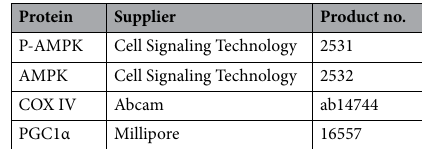
Table 2. Antibodies used in western blot analysis.